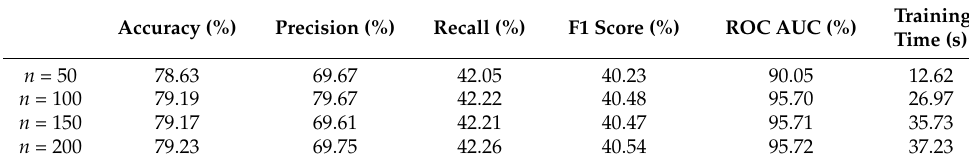
Table 7. Multi-classification performance with the number of tree selected.